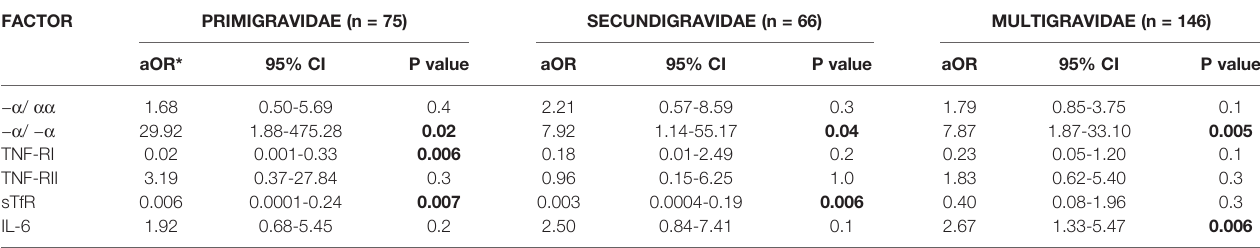
*Adjusted Odds Ratio. Bold values represent signi fi cant differences.